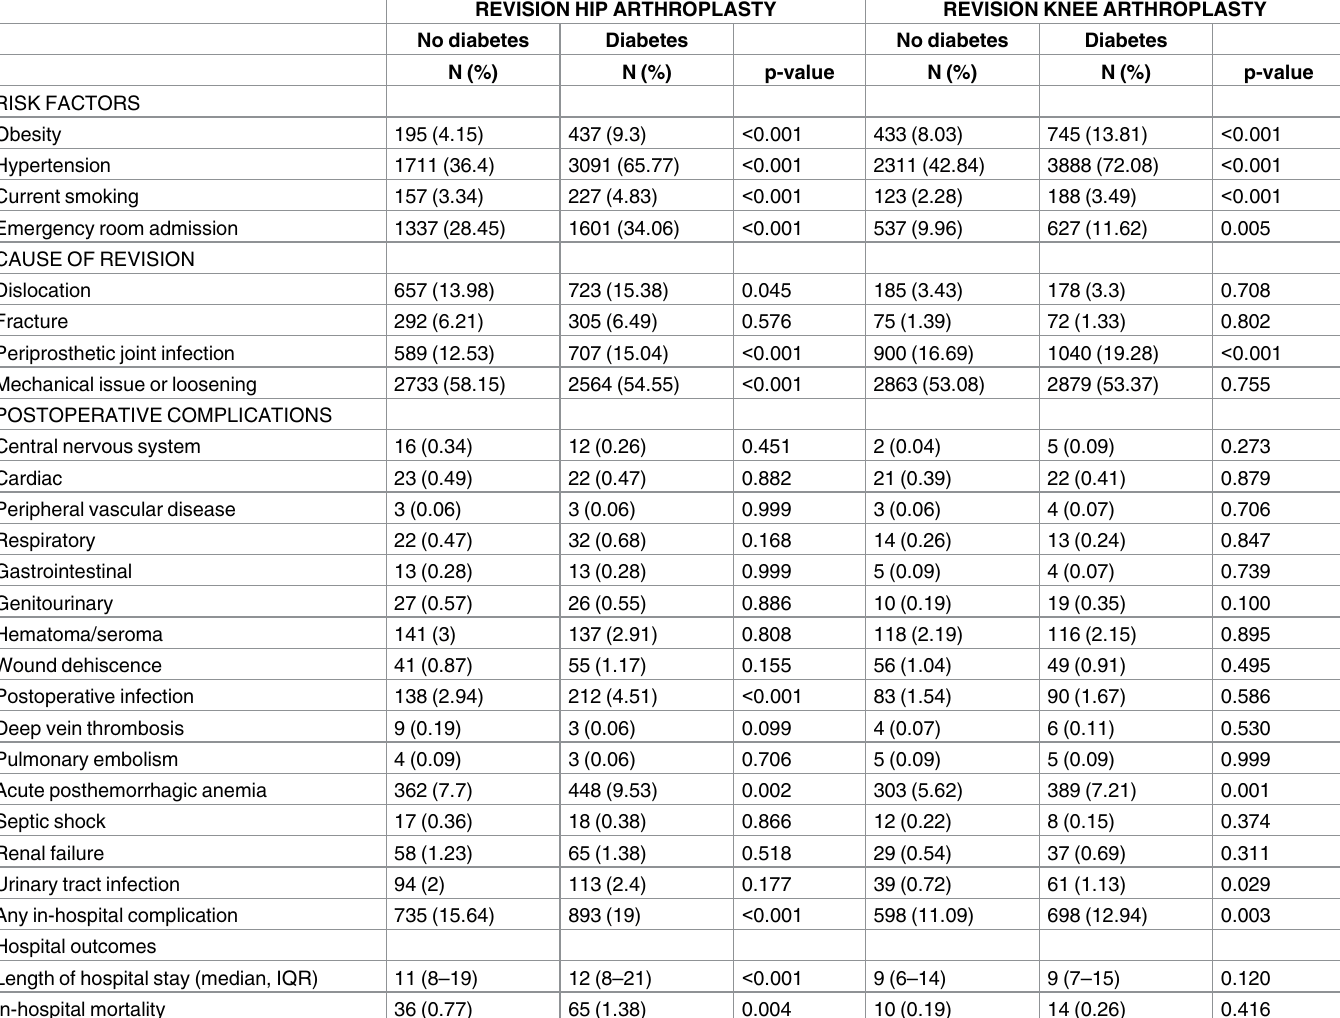
Table 3. Risk factors, emergency room admissions, cause of revision, postoperative complications and hospital outcomes in patients with type 2 diabetes who underwent total revision hip and knee arthroplasty and their matched non-type 2 diabetes controls in Spain,